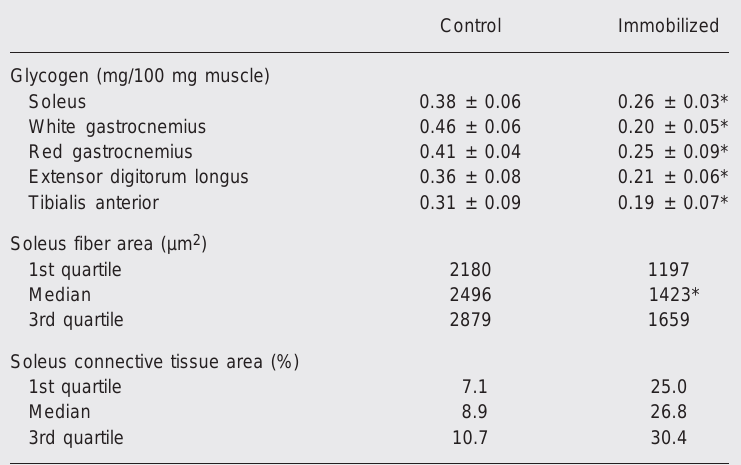
Data are reported as means ± SD (glycogen) and medians (fiber and connective tissue area) for 6 animals per group. *P < 0.05 compared to control (Kolmogorov-Smirnov, Student t -test, Wilcoxon